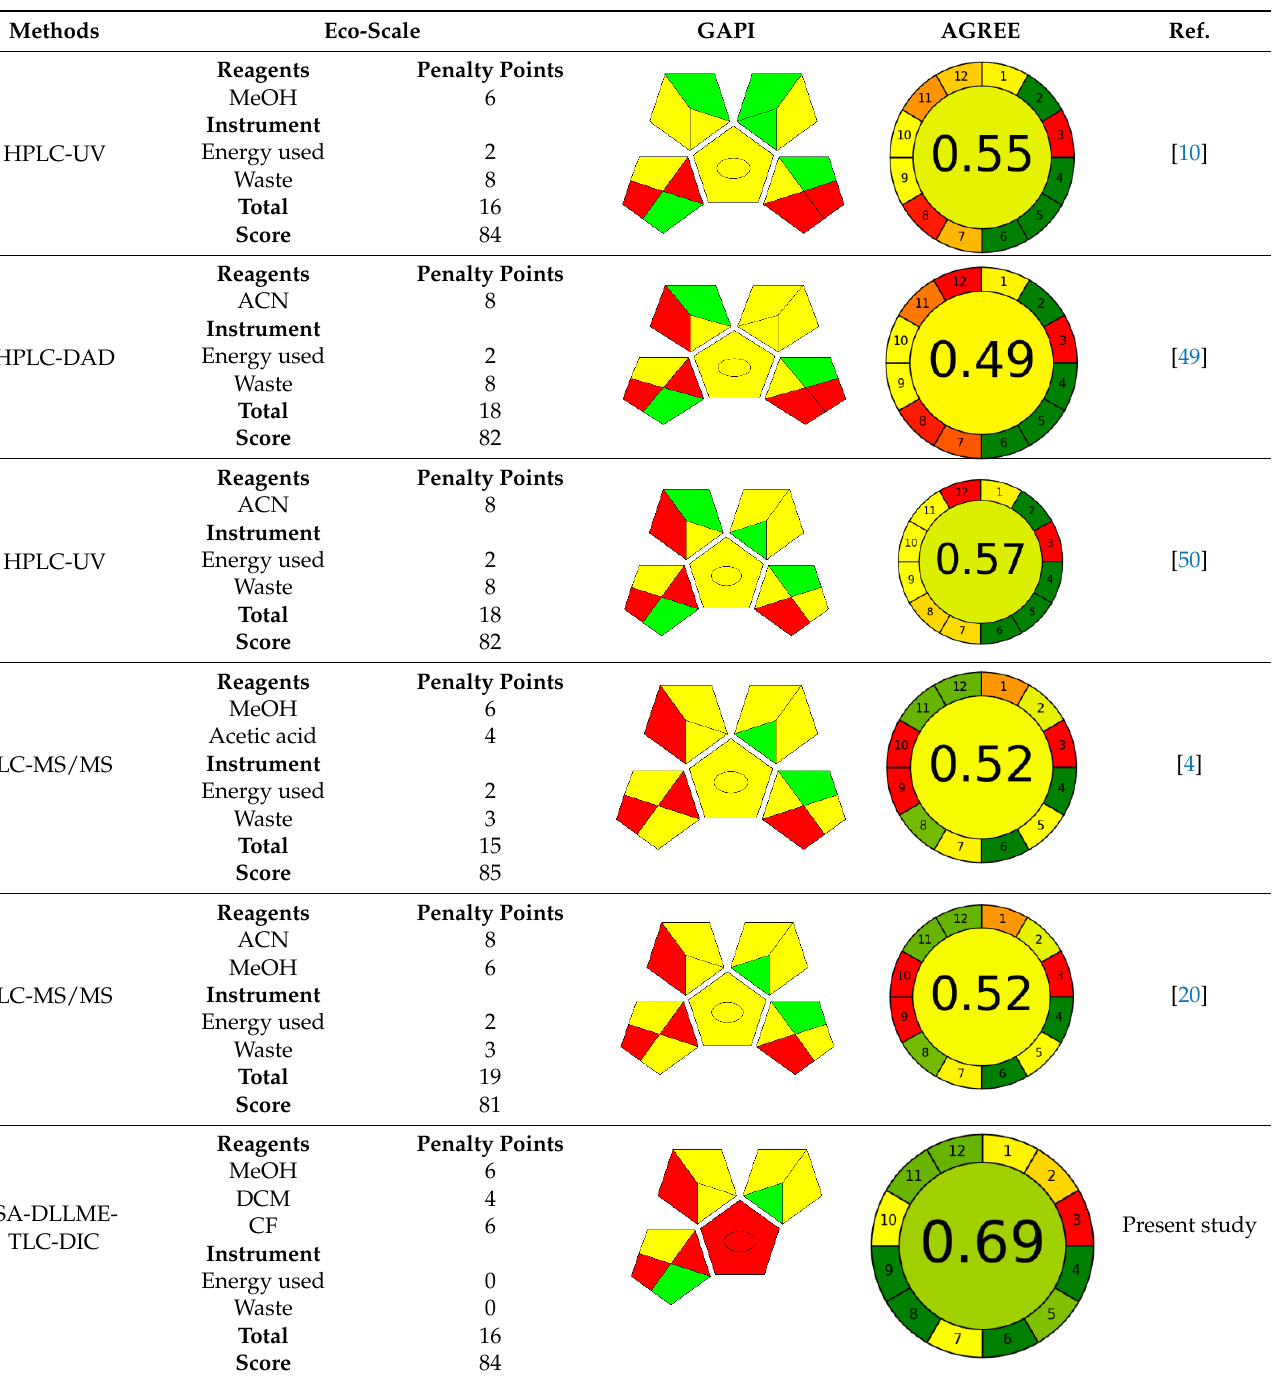
Figure 6. Greenness report sheet for the proposed method calculated by using 12 different greenness criteria with the AGREE software. Table 4. Comparison between the proposed method and previously reported methods for the determination of FAV.